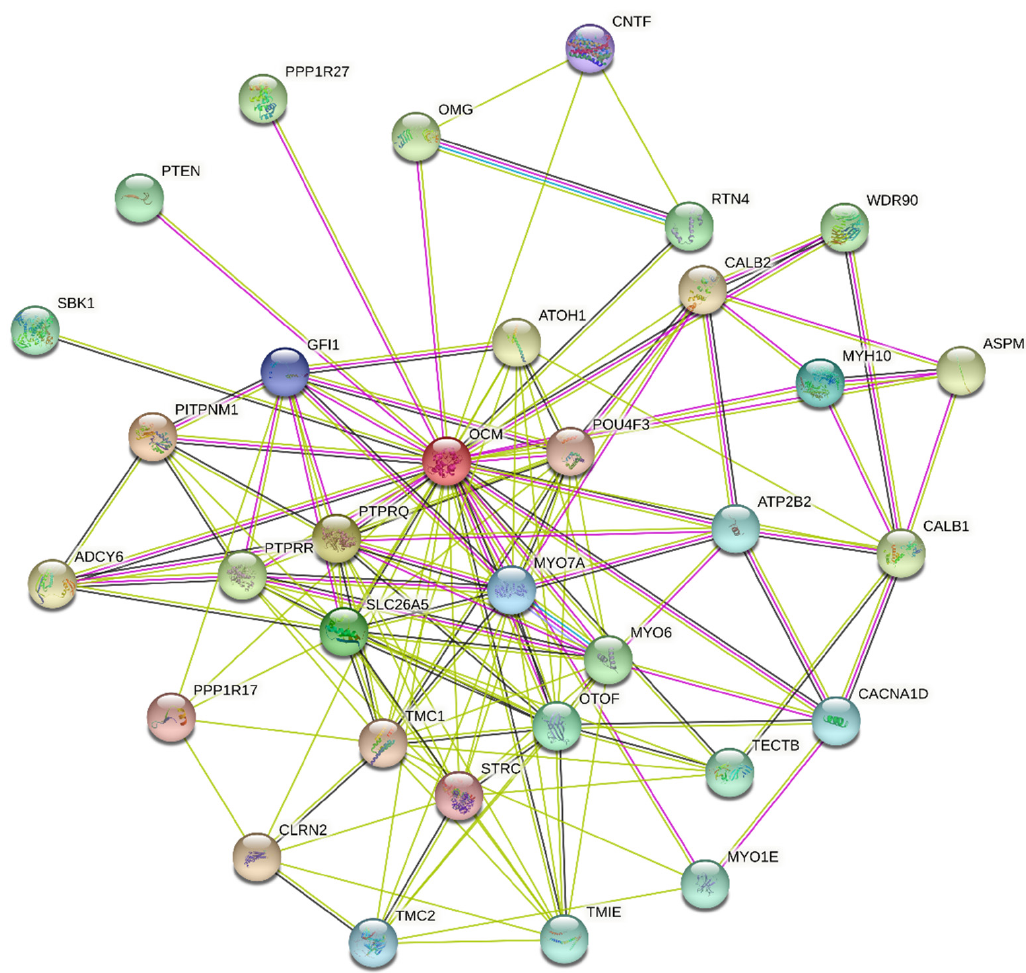
Figure 5. STRING-generated PPI network of human oncomodulin (UniProt ID: P0CE72) using the medium confidence level of 0.4. Seven types of evidence used to build the corresponding network are shown by the differently colored lines: a green line represents neighborhood evidence; a red line—the presence of fusion evidence; a purple line—experimental evidence; a blue line—co-occurrence evidence; a light blue line—database evidence; a yellow line—text mining evidence; and a black line—co-expression evidence [126].